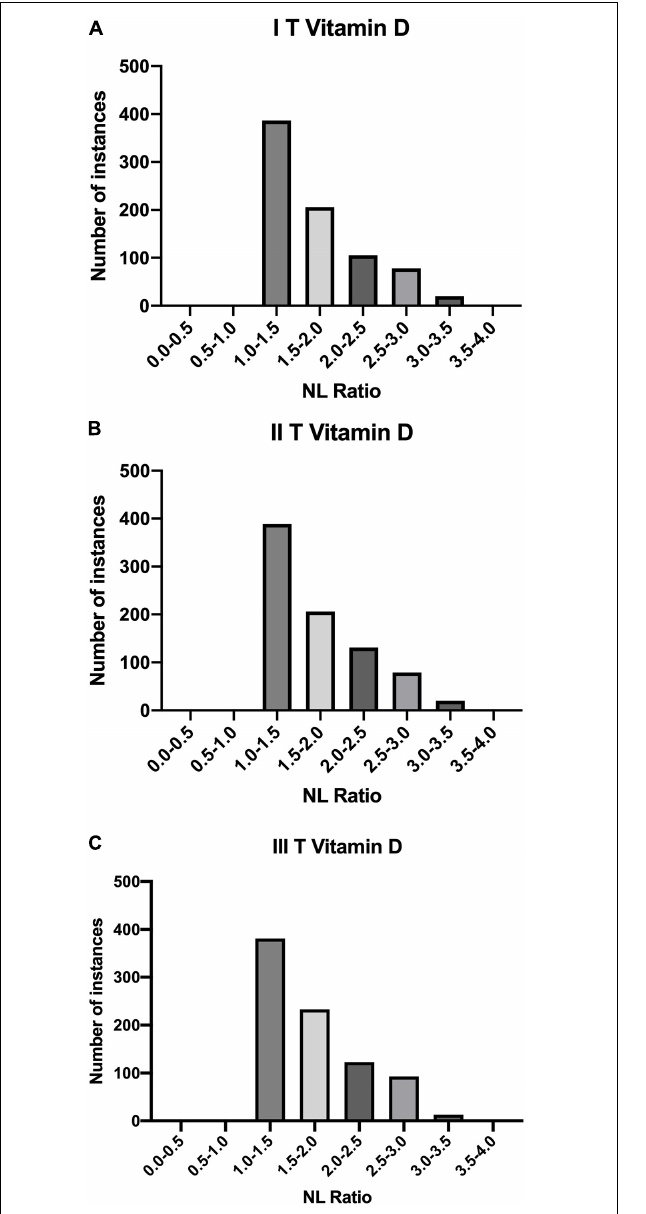
FIGURE 4 | NL Ratio values structure in the studied population. The patients were grouped according to the SII index: (A) Low SII; (B) High SII.